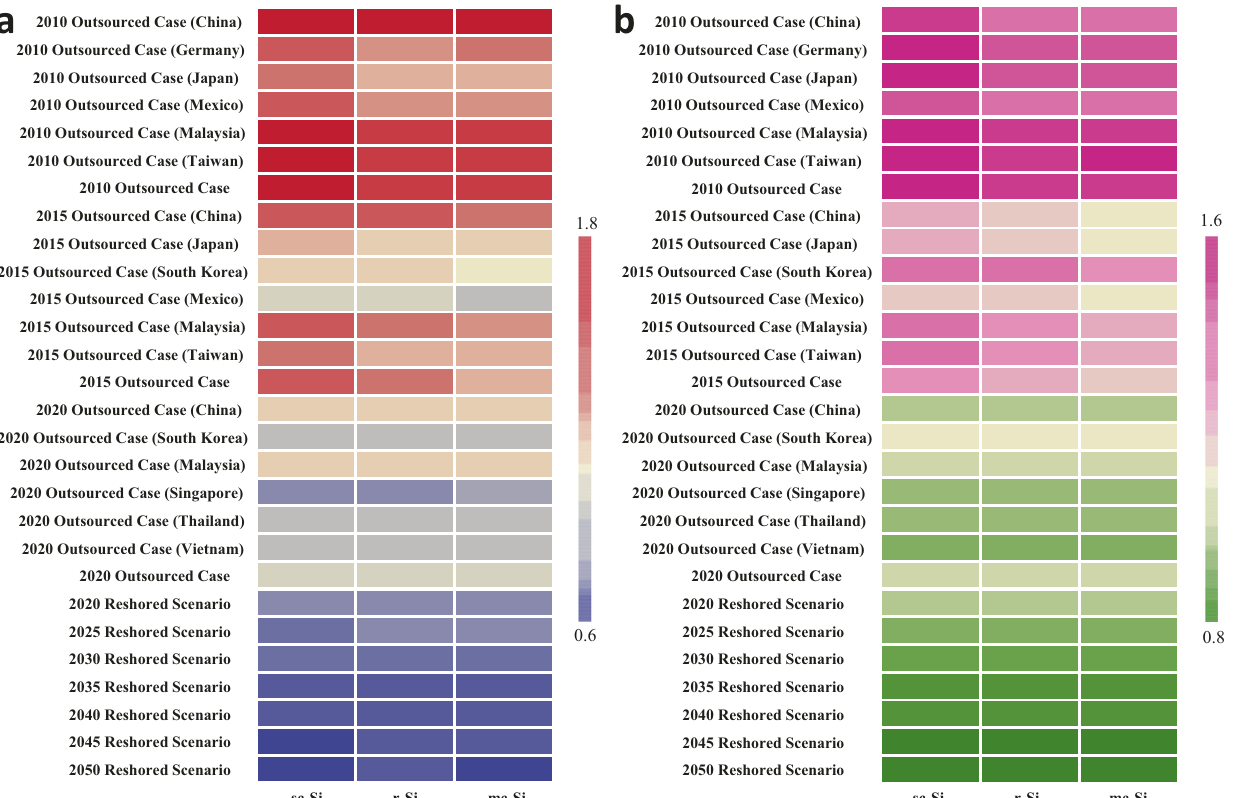
Fig. 6 | Carbon emission factor/greenhouse gas emission factor and energy payback time of outsourced cases (2010, 2015, 2020) and reshored scenarios drop ( a ) carbon emission factor and lower ( b ) energy payback time (EPBT) of manufacturingc-SiPVpanels.Thepresentedresultsarenormalizedandvarybased